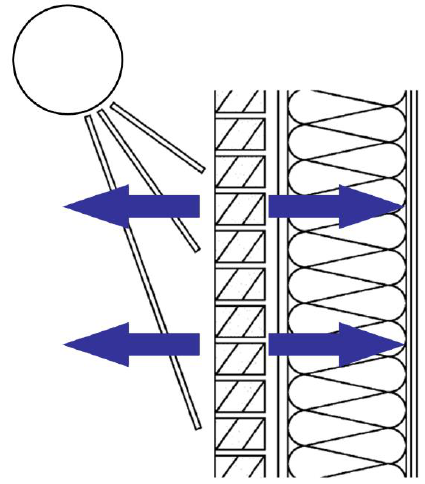
Figure 5. Solar vapor drive and interstitial condensation.